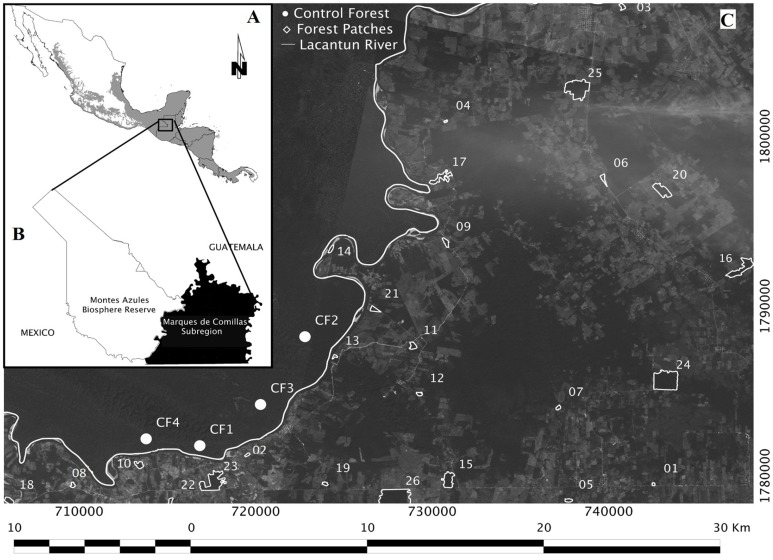
Location of the Mesoamerican biodiversity hotspot (a), and the study area in the Lacandon rainforest, Mexico (b).The 26 forest patches located in the Marqués de Comillas region and the four reference areas studied within the continuous forest of the Montes Azules Biosphere Reserve are also indicated (c).